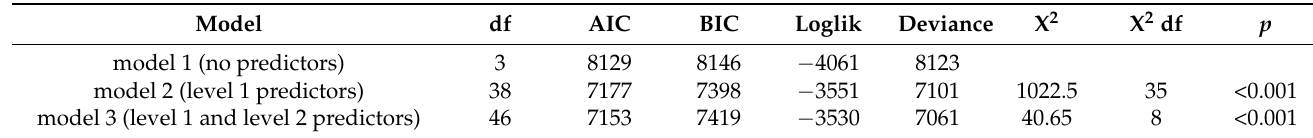
Table 5. Model comparison of model 1, 2 and